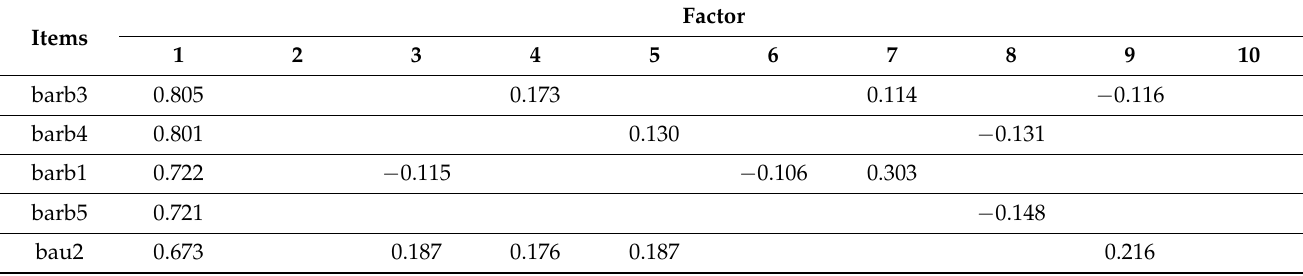
Table 3. Factor loadings of the MT-CHBMS using Principal Axis Factoring with Varimax with Kaiser